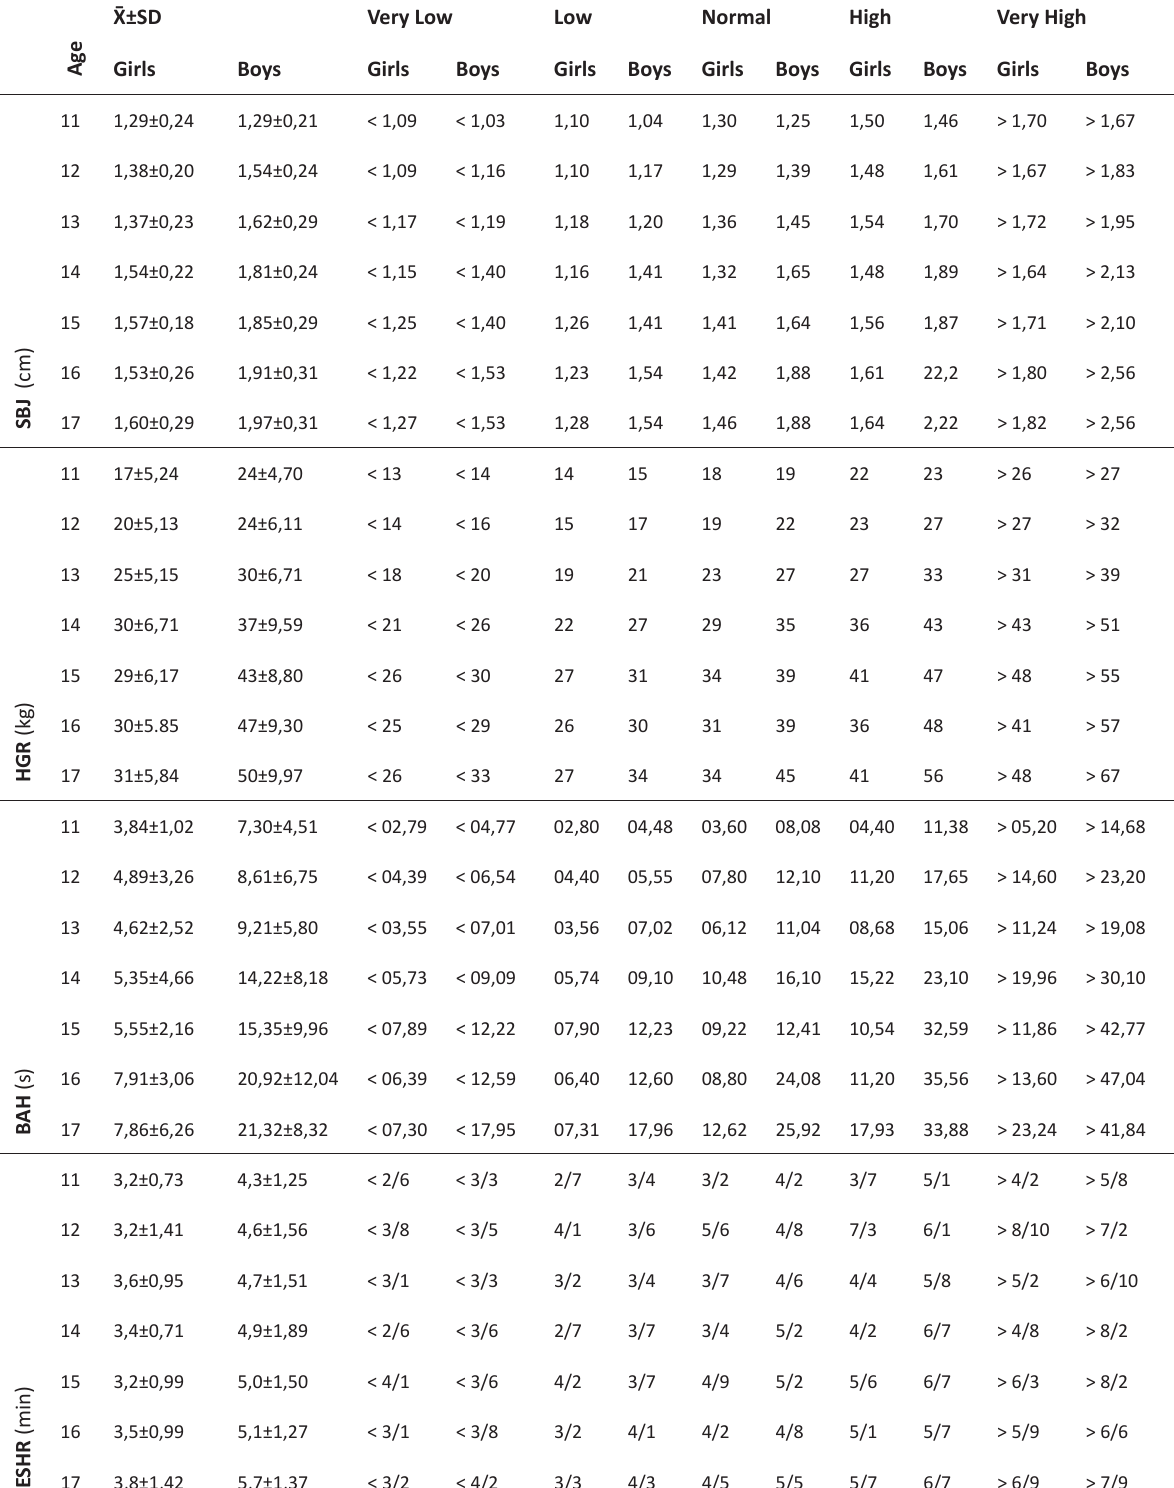
Table 3. Standing Broad Jump, Hand Grip, Bent Arm Hang, 20 Meters Shuttle Run Tests Normative